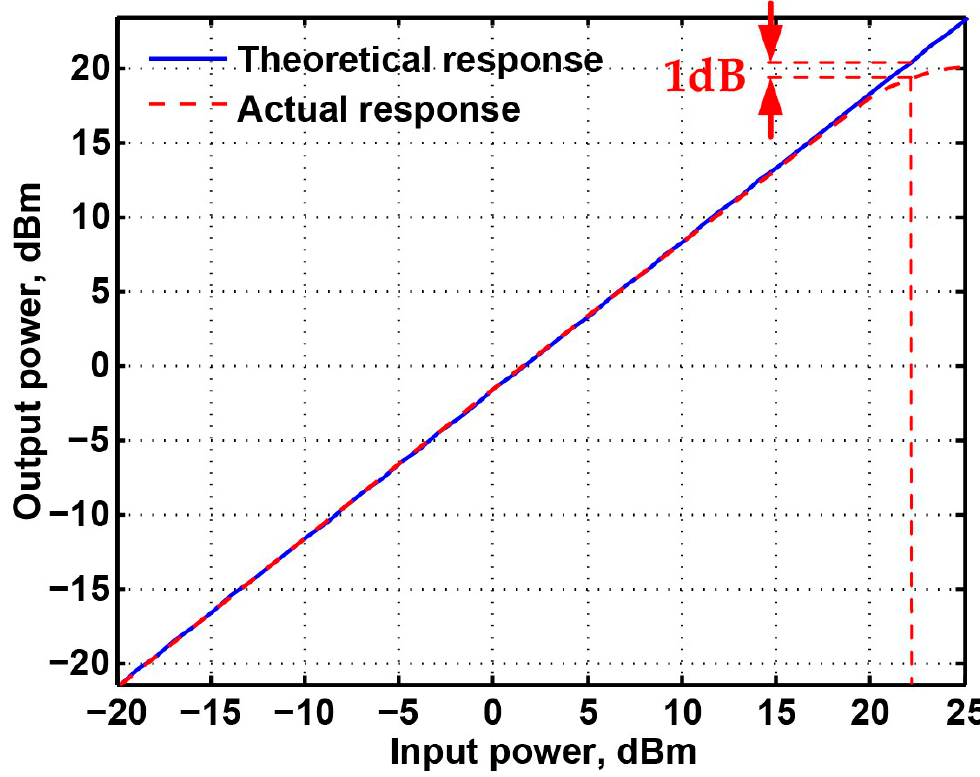
Figure 16. The simulation and measurement P1dB of the BPF with input power at the output voltage V o1 .